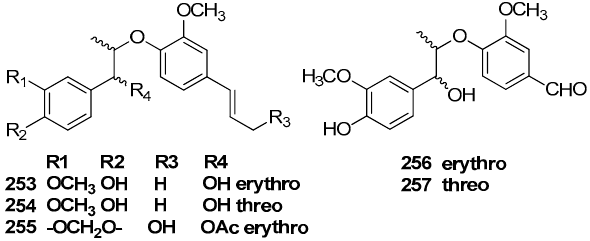
Figure 17. Chemical structures of 8,4’-oxyneolignans.